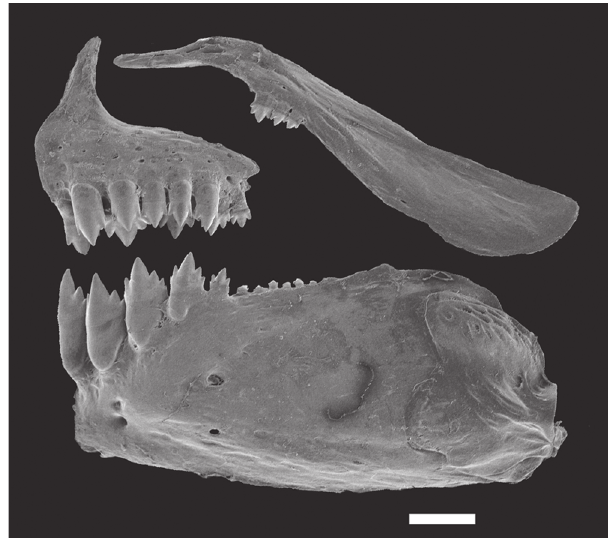
Fig. 2. Astyanax goyanensis , UFRGS 11291, 59.2 mm SL. Scanning electronic microscopy images of the upper and lower jaws, left side, lateral view. Scale bar = 1